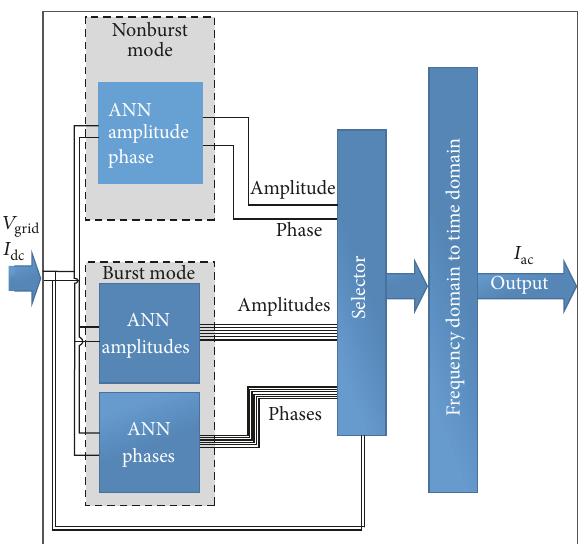
Figure 10: The simplified structure of DDM